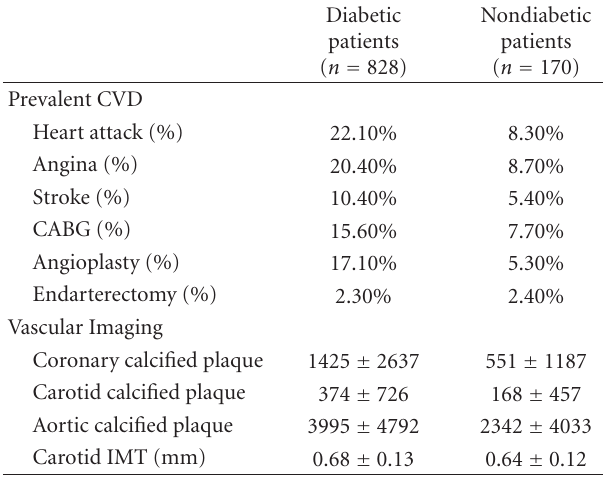
Table 2: Prevalence of CVD (%) and mean ( ± SD) for atheroscle- rosis phenotypes (CorCP, CarCP, AorCP, IMT) for Caucasian participants in the Diabetes Heart Study